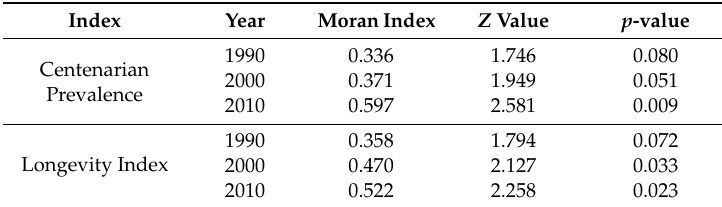
Table 1. Spatial autocorrelation of two longevity indicators in Hechi.